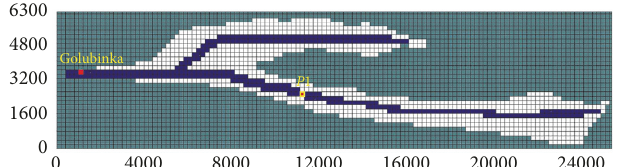
Figure 11: Spatial distribution of hydraulic conductivity coefficients 𝑘 𝑥,𝑦,𝑧 in the fracture layer with a thickness of 1m (from − 2 to − 1m a.s.l.). Blue area indicates the values 𝑘 𝑥,𝑦,𝑧 = 3.0𝐸 −1 , and white 𝑘 𝑥,𝑦,𝑧 = 1.0𝐸 −4 .